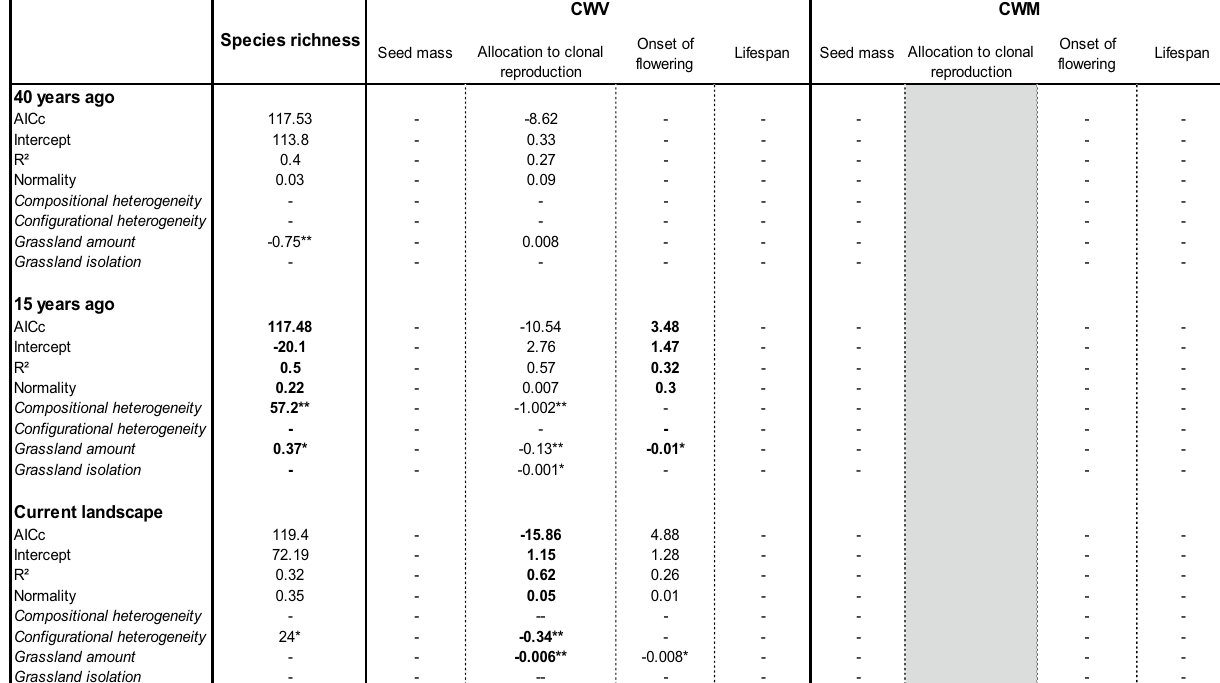
Table 3. Results of linear models testing the effect of landscape predictors on species richness, community weighted variance (CWV) and community weighted mean (CWM) of each trait, calculated from the occurrence rate of plant assemblages in grasslands. AICc, intercept, R 2 and Shapito test for normality of residuals of each significant model are indicated. Estimates of the landscape predictors and their significance levels (***p < 0.001, **p < 0.01, *p < 0.05) are indicated. Non-significance of models and landscape predictors (–) are indicated. Selected best-fitting models meeting the conditions of lowest AICc (ΔAICc < 2) and normal residuals are indicated by bold font. Models in normal font are included to illustrate the ΔAICc between significant models. The trait ‘flowering duration’ was not considered here because the CWVs were found randomly distributed with the null model NM2. The trait ‘allocation to clonal reproduction’ in the CWM section is colored in grey because CWMs for this trait were not calculated as the CWV was found divergent with the null model